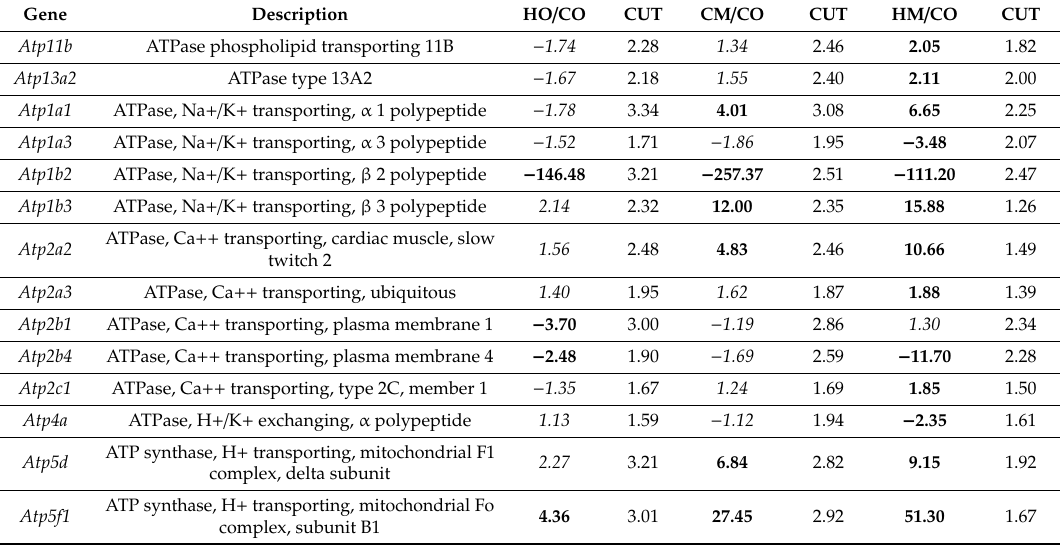
Table 2. Significantly up- (positive fold-change in bold numbers) and downregulated (negative fold-change in bold numbers) ATPases, cytochrome c oxidases, and NADH dehydrogenases in the three PH rat models. Note the range of the CUTs, from 1.24 (for the regulation of Ndufv3 in HM vs. CO) to 3.68 (for the regulation of Cox6a1 in HO vs. CO). Our procedure to determine the cut-o ff for the absolute fold-change for every gene in each comparison instead of using a fixed cut-o ff (like 1.5 × ) eliminated the false regulations (expression ratio in Italics, e.g., Atp11b in HO / CO), whose absolute (although over 1.5 × ) fold-change was below the CUT (2.28) computed for that gene in the compared conditions. Description